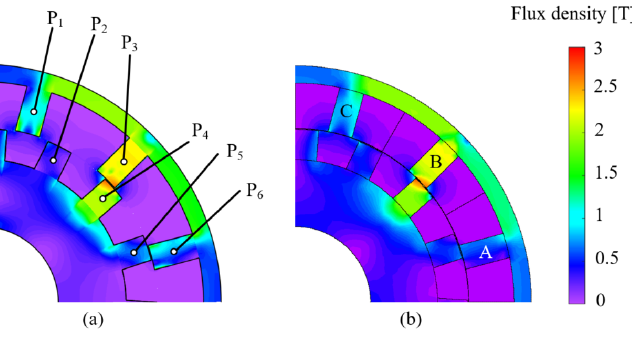
Figure 26. Magnetic flux density contours at θ elec , phA = 240 ◦ for the current waveform in Figure 21. Table 11. Flux density comparison at points P 1 , P 2 , P 3 , P 4 , P 5 , and P 6 for the dynamic operation in Figure